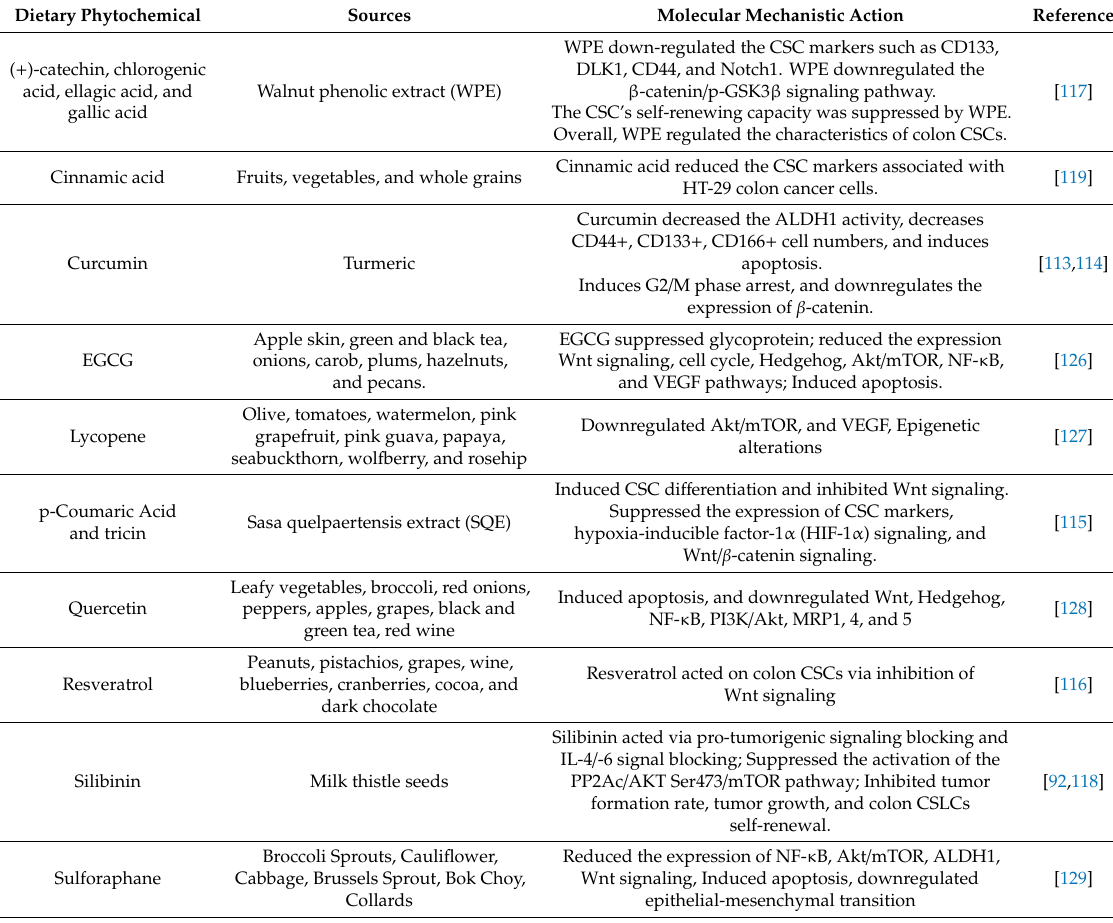
Table 3. List of phytochemicals and their anti-tumorigenic e ff ect on colon